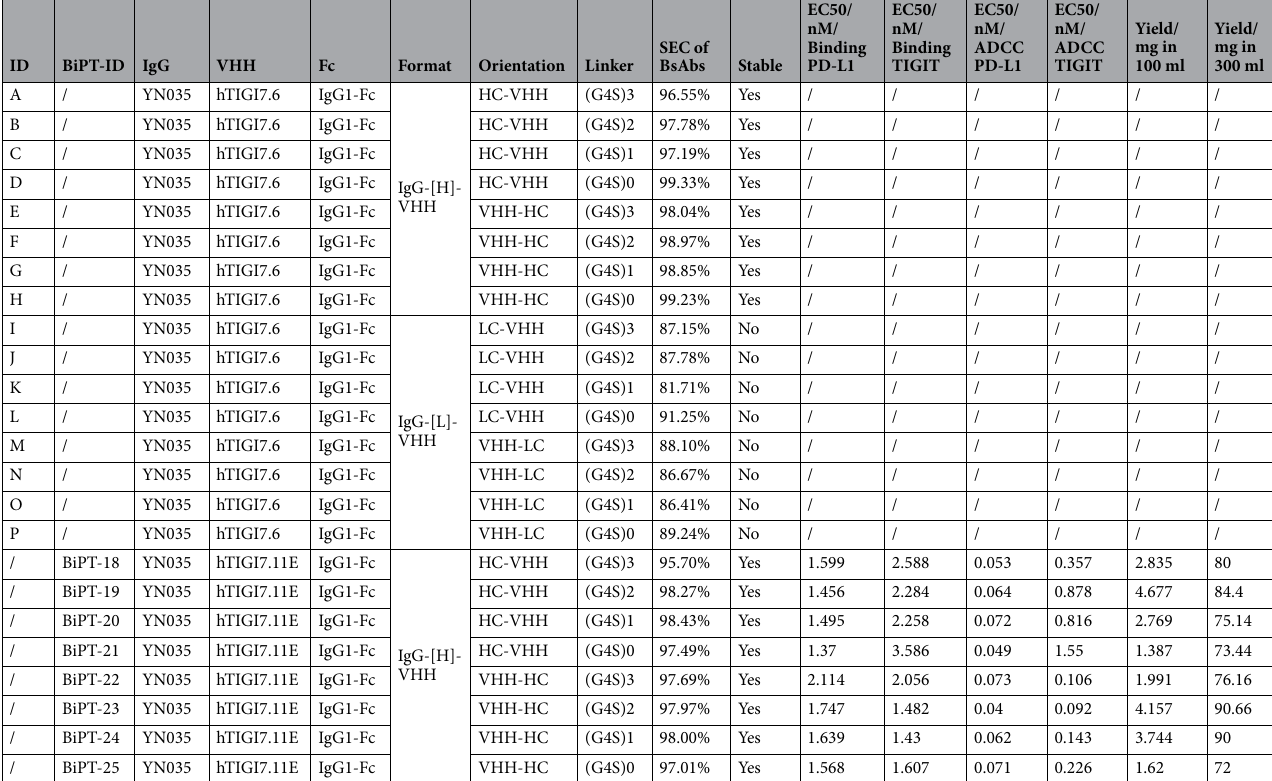
Table 1. Summary of bispecific